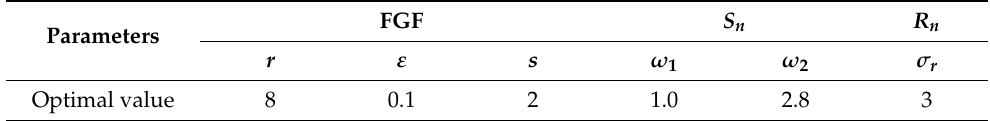
Table 1. Parameters in the proposed method.